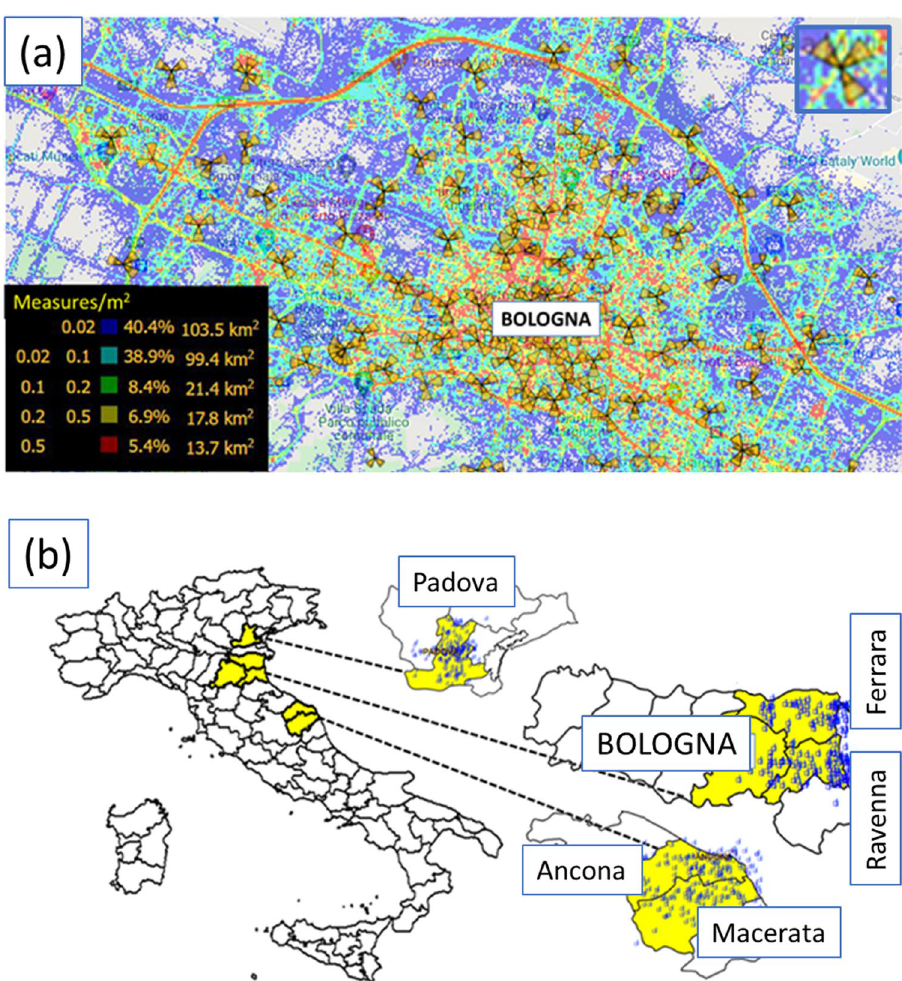
Figure 1. ( a ) A view of MDT sample density [measures/m 2 ] in Bologna City. Cells are visible as triangular oriented sectors. Points for the geographical mapping representation are pixels having a 1 m side length. ( b ) The six different Italian Nord-Est areas (in yellow) involved in the study collectively cover 15.051 km 2